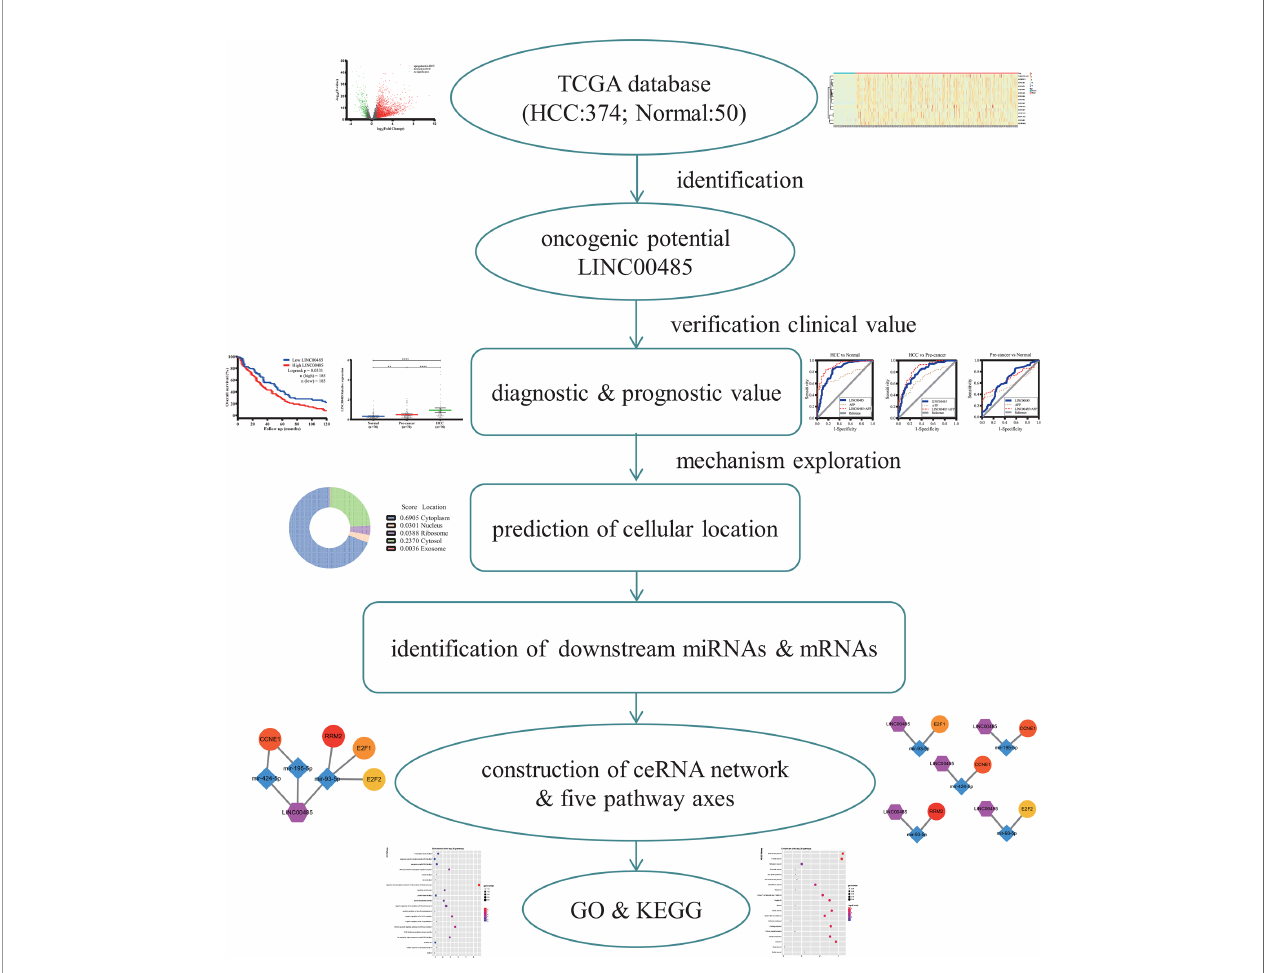
FIGURE 1 | The fl ow diagram of the entire work. TCGA, The Cancer Genome Atlas; GO, Gene oncology; KEGG, Kyoto Encyclopedia of Gene and